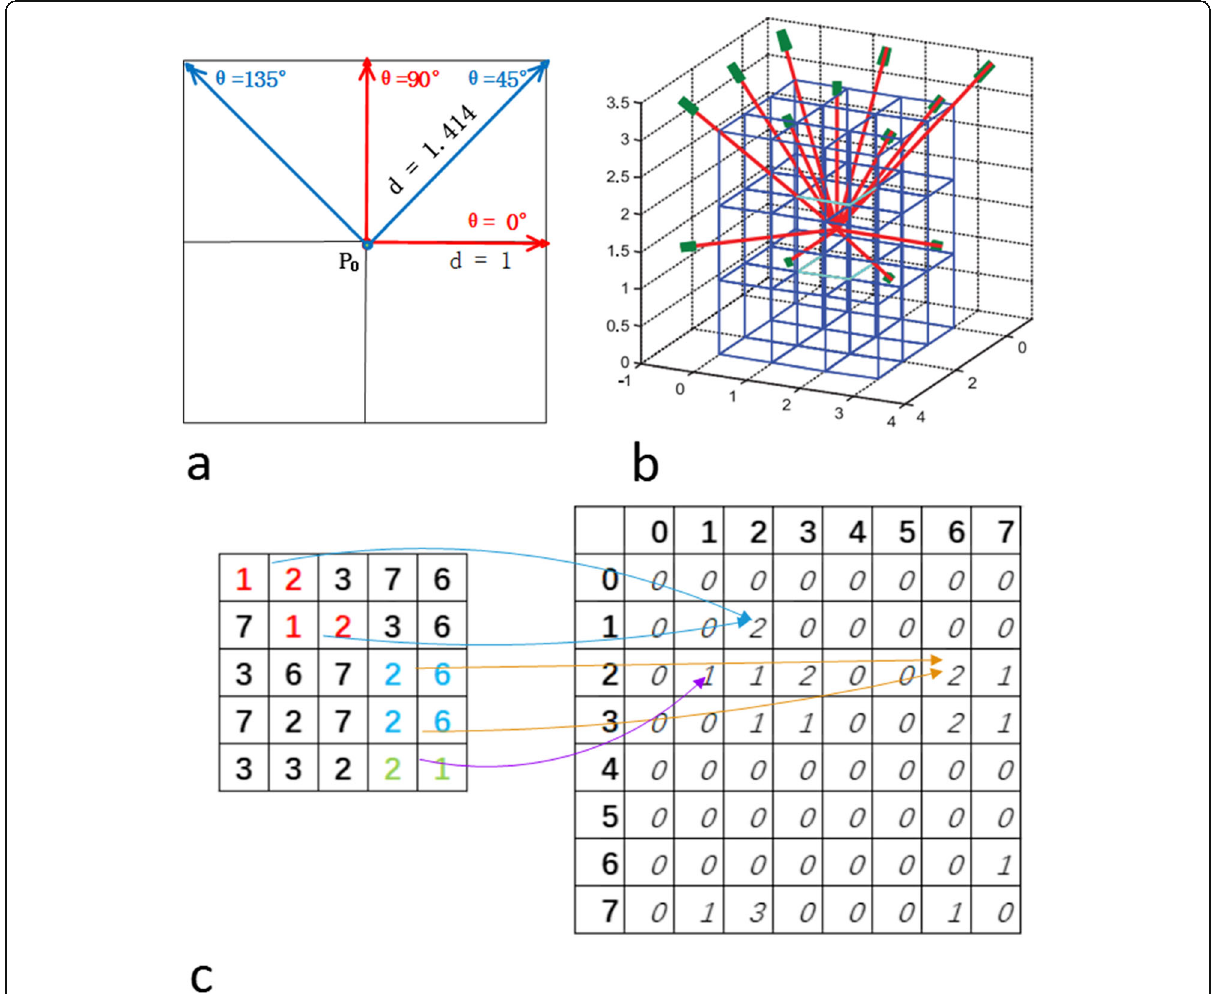
Fig. 2 Illustration of co-occurrence matrix of two-dimensional images. a : Two-dimensional GLCM calculation; b : Three-dimensional GLCM calculation; c : A GLCM example when angle( θ ) = 0°, displacement = 1. GLCM: Gray-level co-occurrence